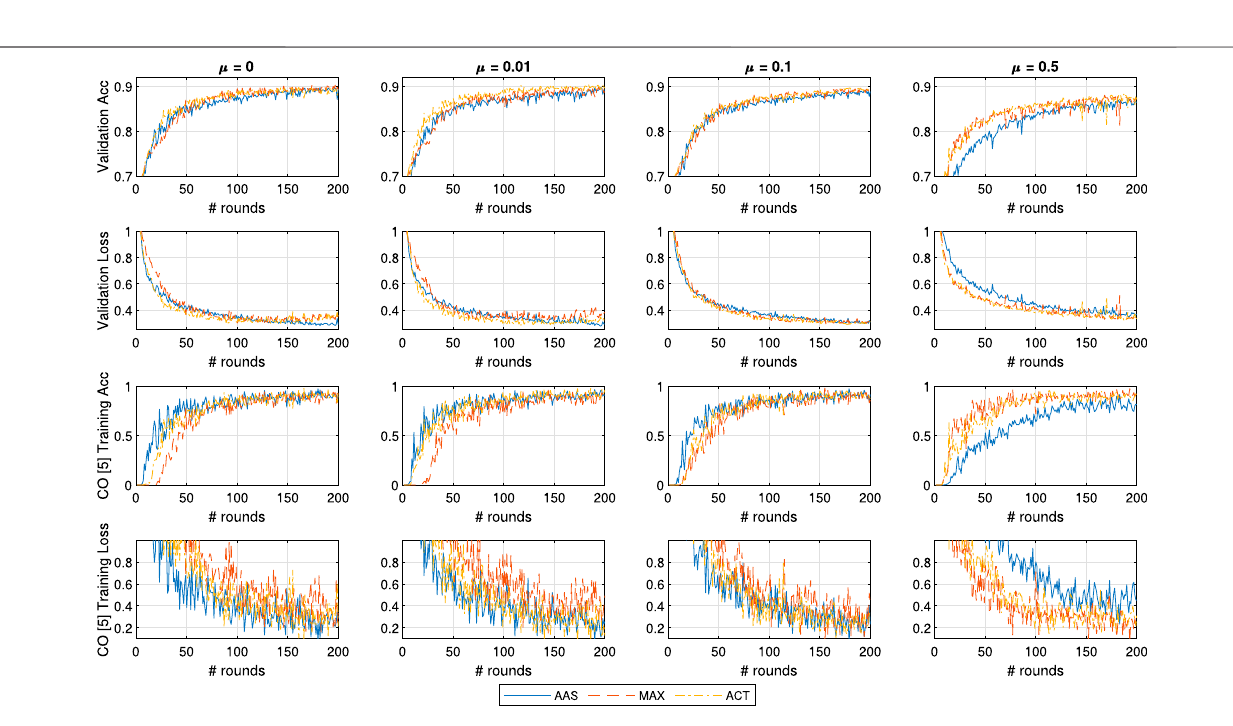
Frontiers in Communications and Networks |